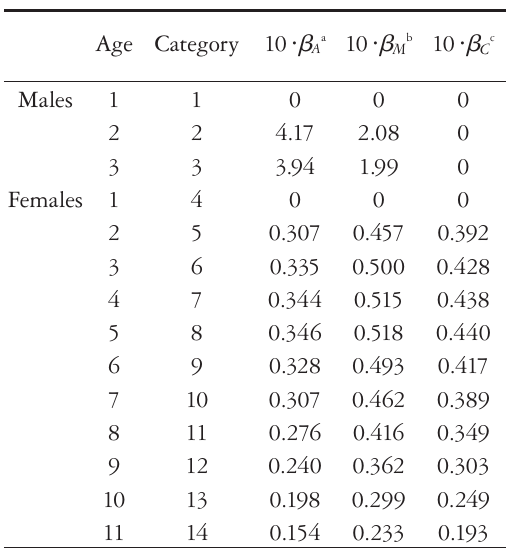
Table 2. Influence of the selective advantages ( A , M and C ) on the long-term genetic contributions for individuals within each category, when the whole population is selected (Case